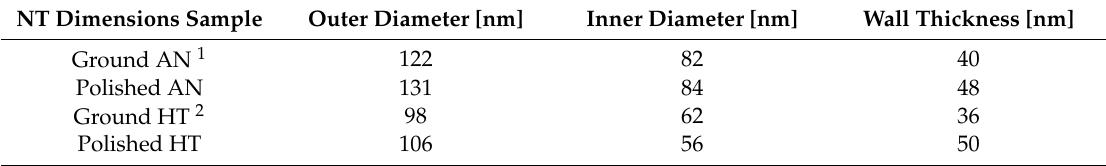
Note: 1 as-anodized; 2 anodized-heat treated.